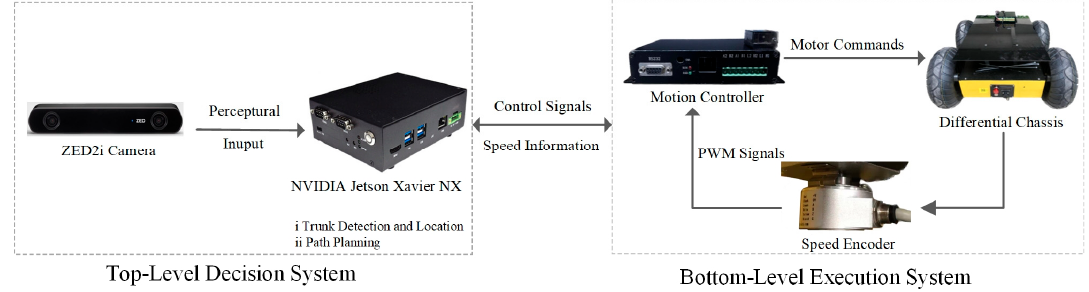
Figure 11. Schematic diagram of the robot navigation system.